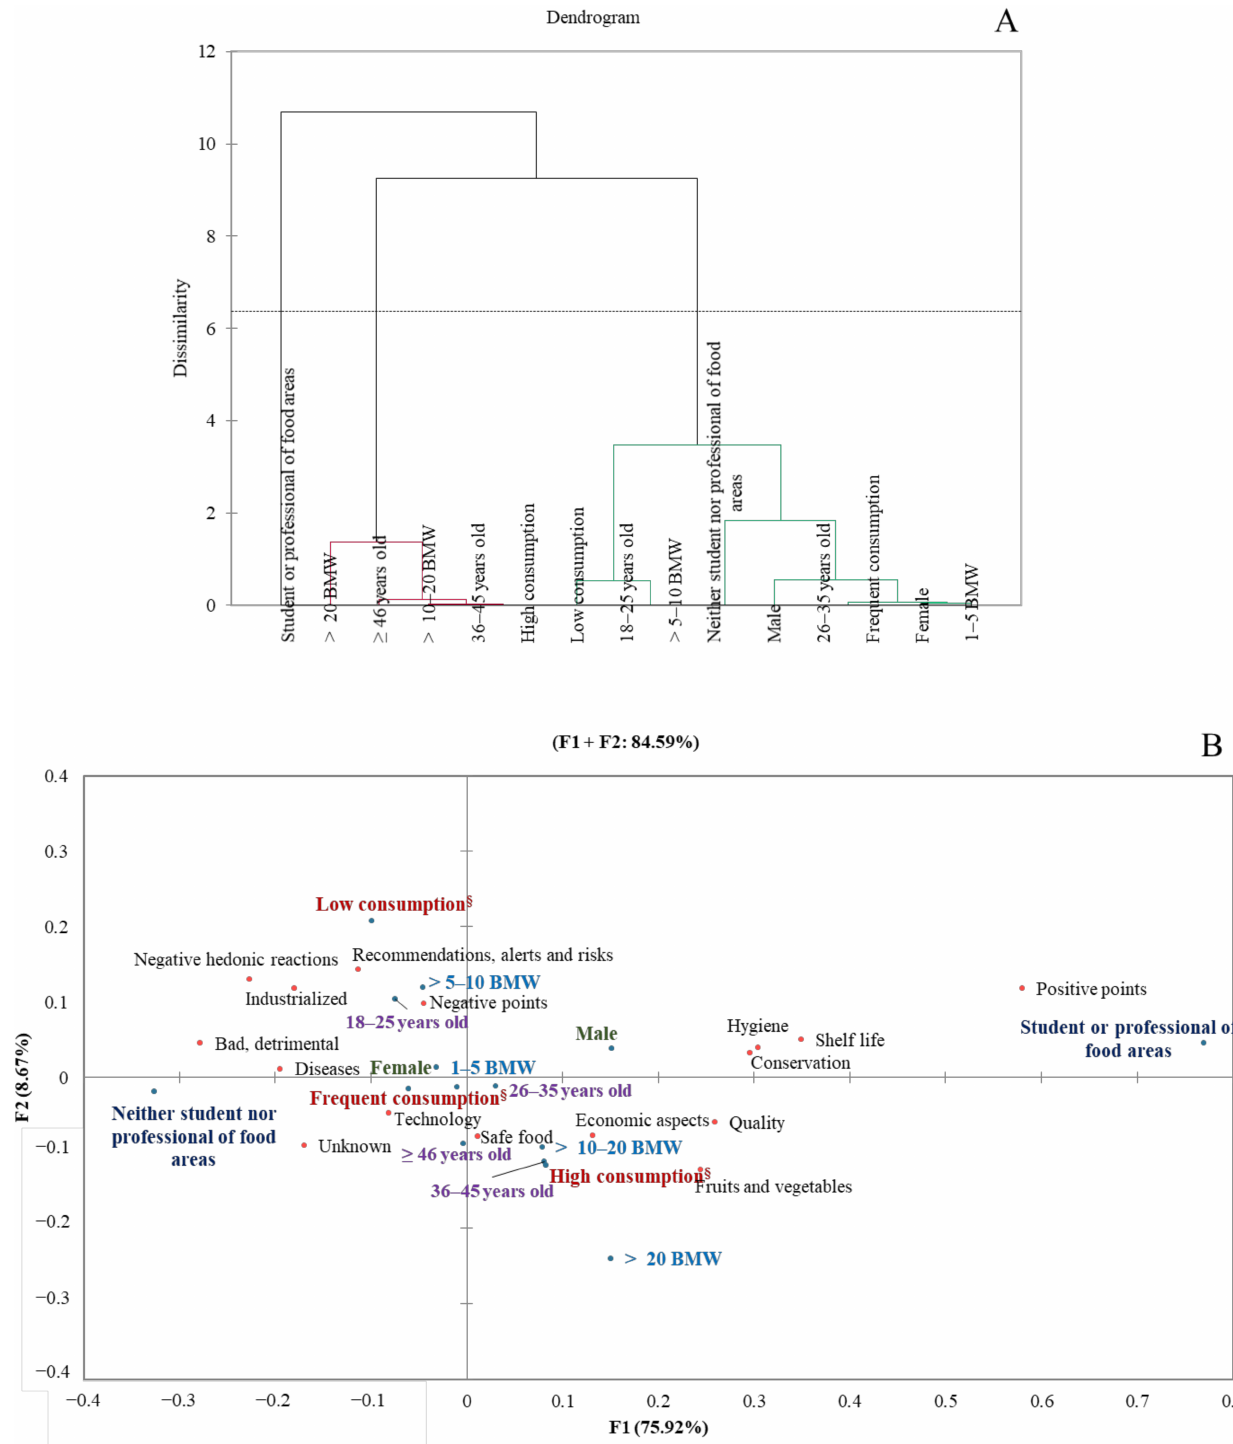
Figure 2. Hierarchical cluster analysis ( A ) and correspondence analysis of the consumer charac- teristics (blue) and frequency of mention of the categories (red) from free word association task concerning ultraviolet (UV)-treated foods ( B ) at 5% significance level. BMW—Brazilian minimum wage in Brazilian currency (Real). Low consumption—consumers who never or rarely consume industrialized products; frequent consumption—consumers who consume frequently industrialized products; high consumption—consumers who consume daily industrialized products or more than once a